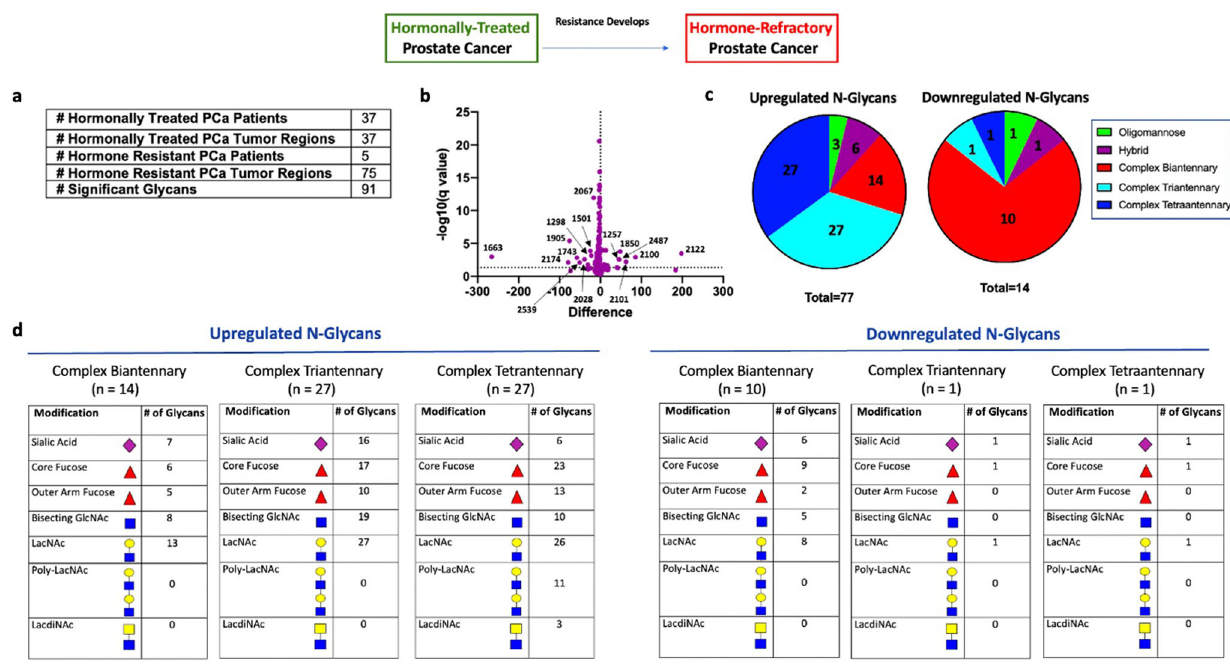
Fig. 4 N-linked glycosylation changes in hormone resistant tumors. a Table demonstrating the number of hormonally treated and hormone resistant PCa patients studied, the number of annotated tumor regions within each group, and number of signi fi cant glycans between all hormonally treated tumor regions ( n = 37) and all hormone resistant tumor regions ( n = 75). b Volcano plot comparison of all glycans in annotated hormonally treated PCa tumor regions ( n = 37) and annotated hormone resistant PCa tumor regions ( n = 75). 91/150 glycans detected demonstrate statistical signi fi cance between the two groups with 77 structures upregulated and 14 structures downregulated. c Circle graph demonstrating the proportion of upregulated and downregulated glycans within each major structural category. Complex tri- and tetraantennary glycans represent the largest proportion of upregulated glycans while complex biantennary glycans represent the largest proportion of downregulated glycans. d Tables demonstrating common structural modi fi cations associated with upregulated and downregulated N -glycans in each major structural class showing a signi fi cant